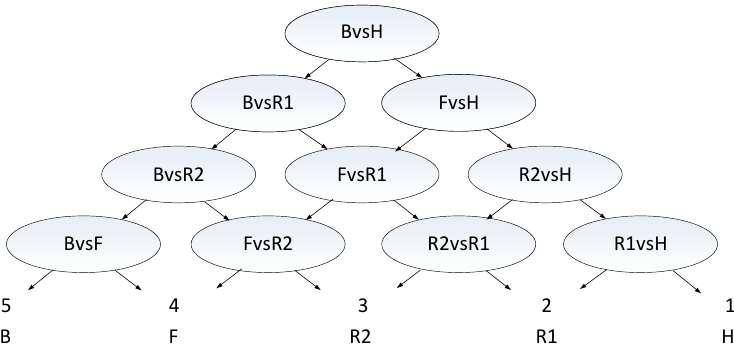
Figure 19. Classification system based on multiple one-versus-one binary classifiers and directed acyclic graph for five LSS targets.